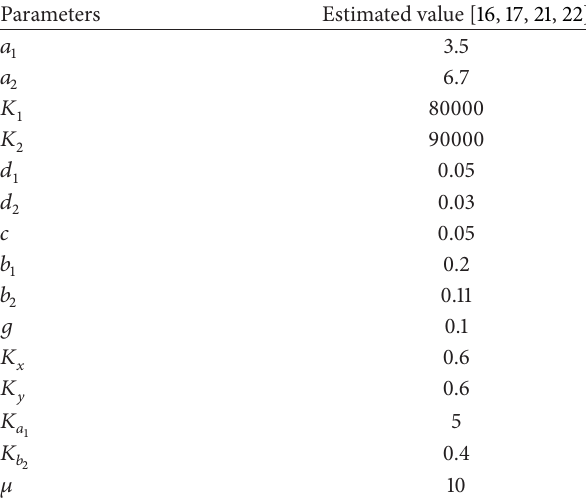
Table 1: Estimated